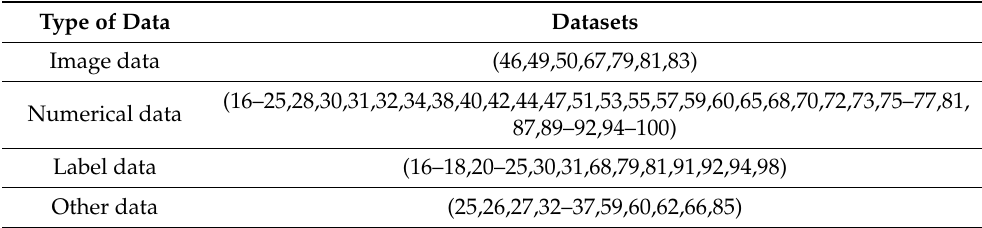
Table 2. Reviewed datasets divided according to data type.